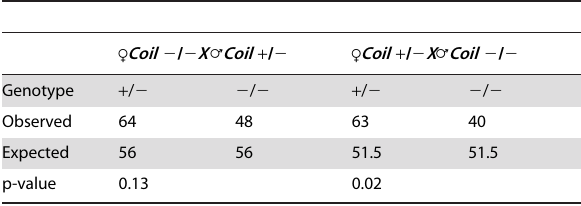
Table 2. Contribution of the uterine environment to neonatal viability.